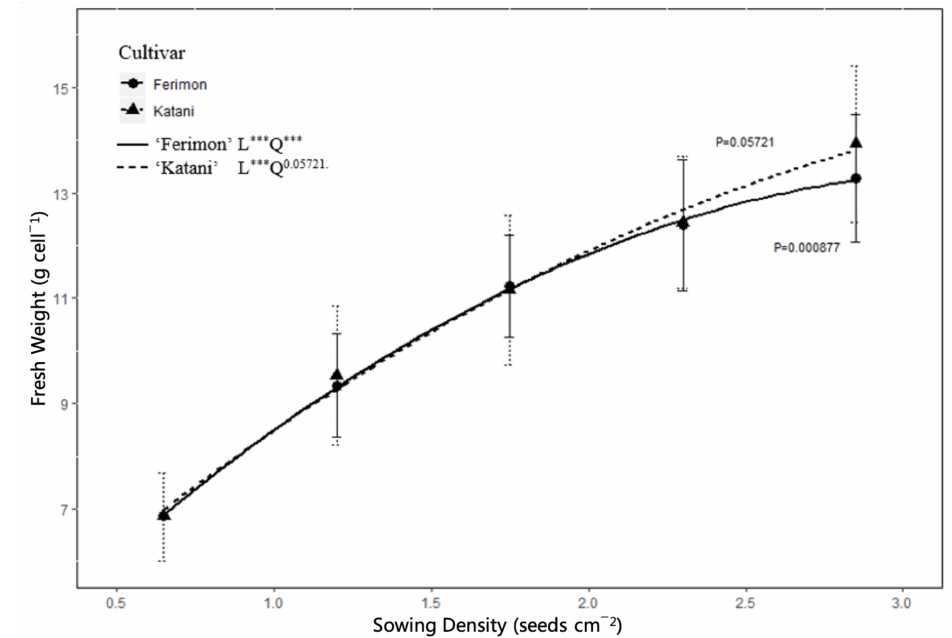
Figure 2. Fresh weight per cell of baby leaf hemp ‘Ferimon’ and ‘Katani’ in response to increasing sowing density. Data represent mean ± SE (Standard Error) of 15 experimental units (3 crop cycles each with 5 experimental units per treatment per cultivar). Significance of linear (L) and quadratic (Q) regression represented as ***, significant at p ≤